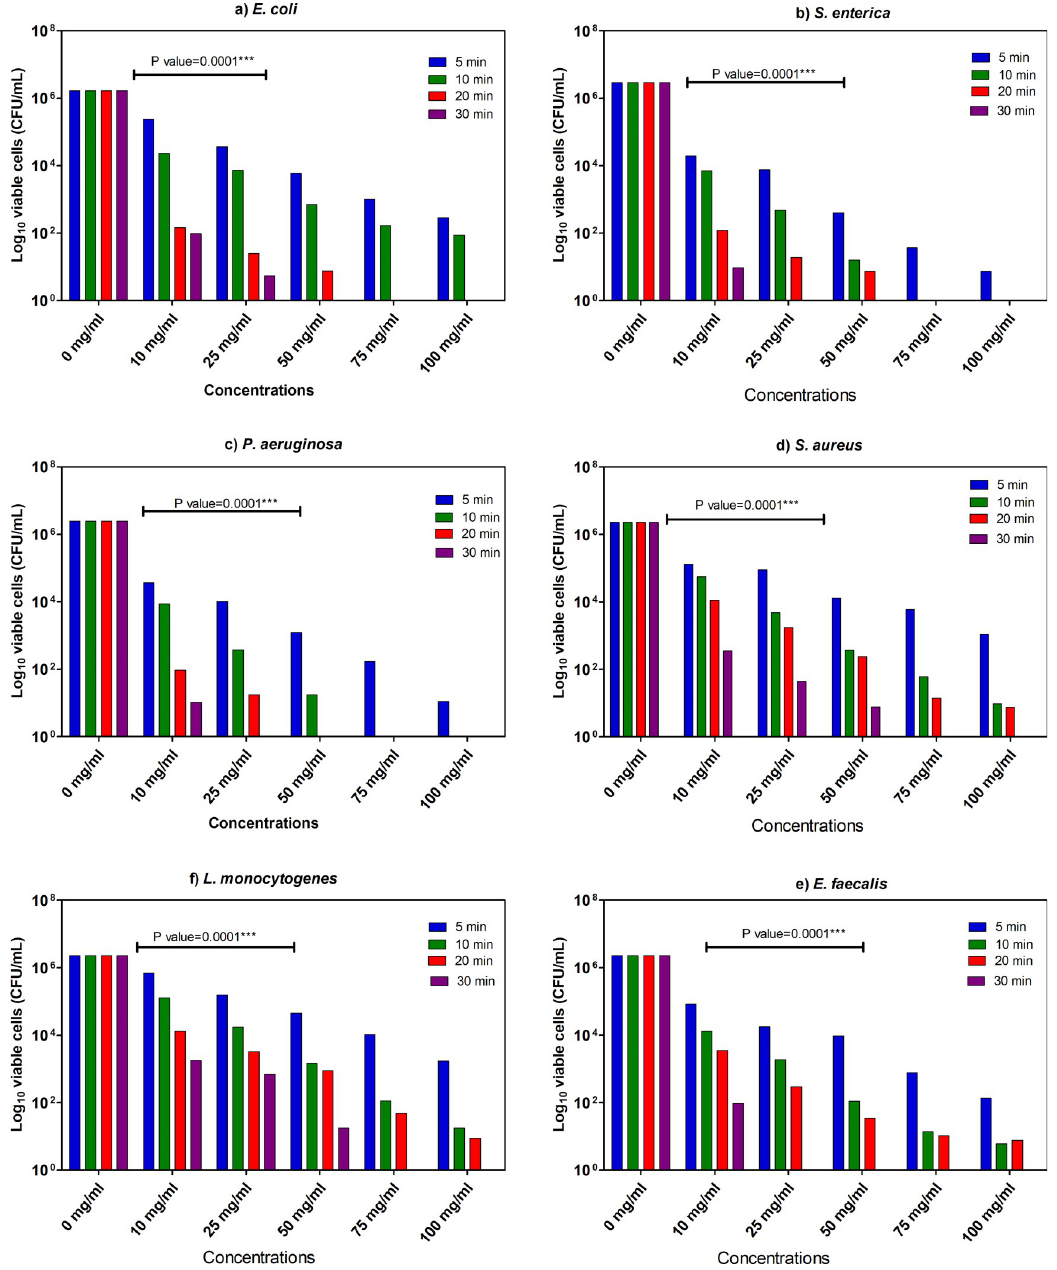
Fig 3. Minimum inhibitory concentration values of methanol extract of A . indica L. towards examined bacterial species. The remaining viable cell populations after various exposure time intervals of 5, 10, 15, and 30 min to the extracts are also shown. Two- way analysis of variance ( ANOVA ) states �� indicates moderate correlation ( p � 0.01), ��� indicates high correlation ( p � 0.001).